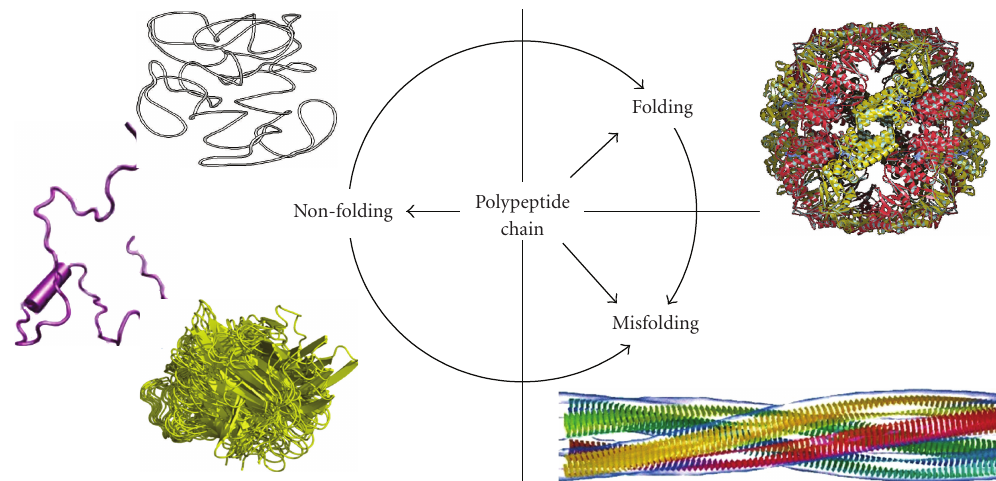
Figure 1: Fate of a polypeptide chain. Left . Three structures representing typical IDPs with di ff erent disorderedness levels (from top to bottom): native coil, native premolten globule, and native molten globule. Right . Top structure illustrates a well-folded protein, whereas the bottom structure represents one of the products of protein misfolding—a molecular model of the compact, 4-protofilament insulin fibril (http://people.cryst.bbk.ac.uk/ ∼